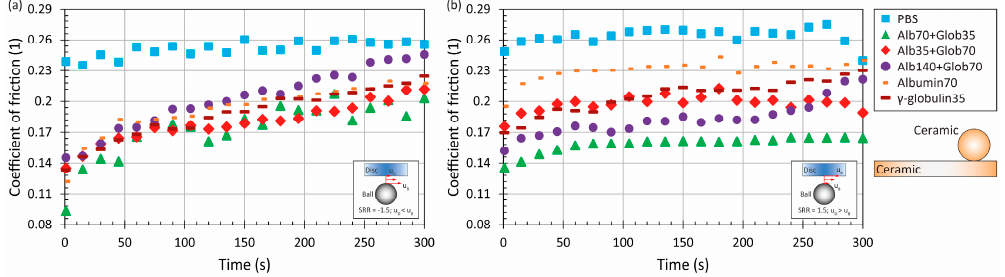
Figure 8. Development of CoF as a function of time for ceramic-on-ceramic pair at higher mean speed under negative ( a ) and positive ( b ) sliding conditions for various model fluids.